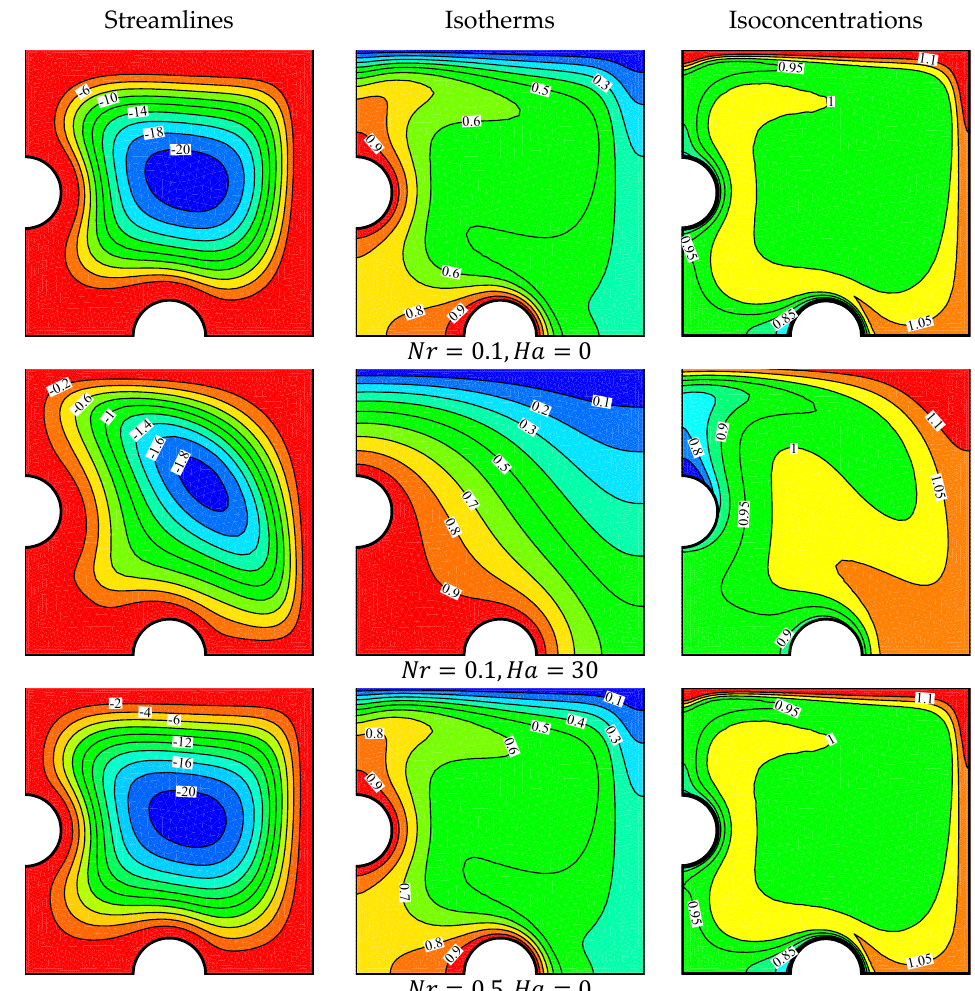
Figure 8. Isoconcentrations, streamlines and isotherms at different Nr and Ha for γ r = 1, Mn f = 1000, Ra = 10 5 , Nb = Nt = 0.5, and Le =